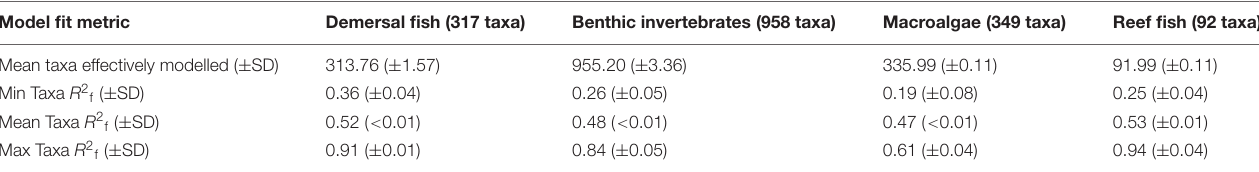
TABLE 1 | Mean ( ± SD) model fit metrics of individual taxa ( R 2 f ) from bootstrapped gradient forest (GF) models. Model fit